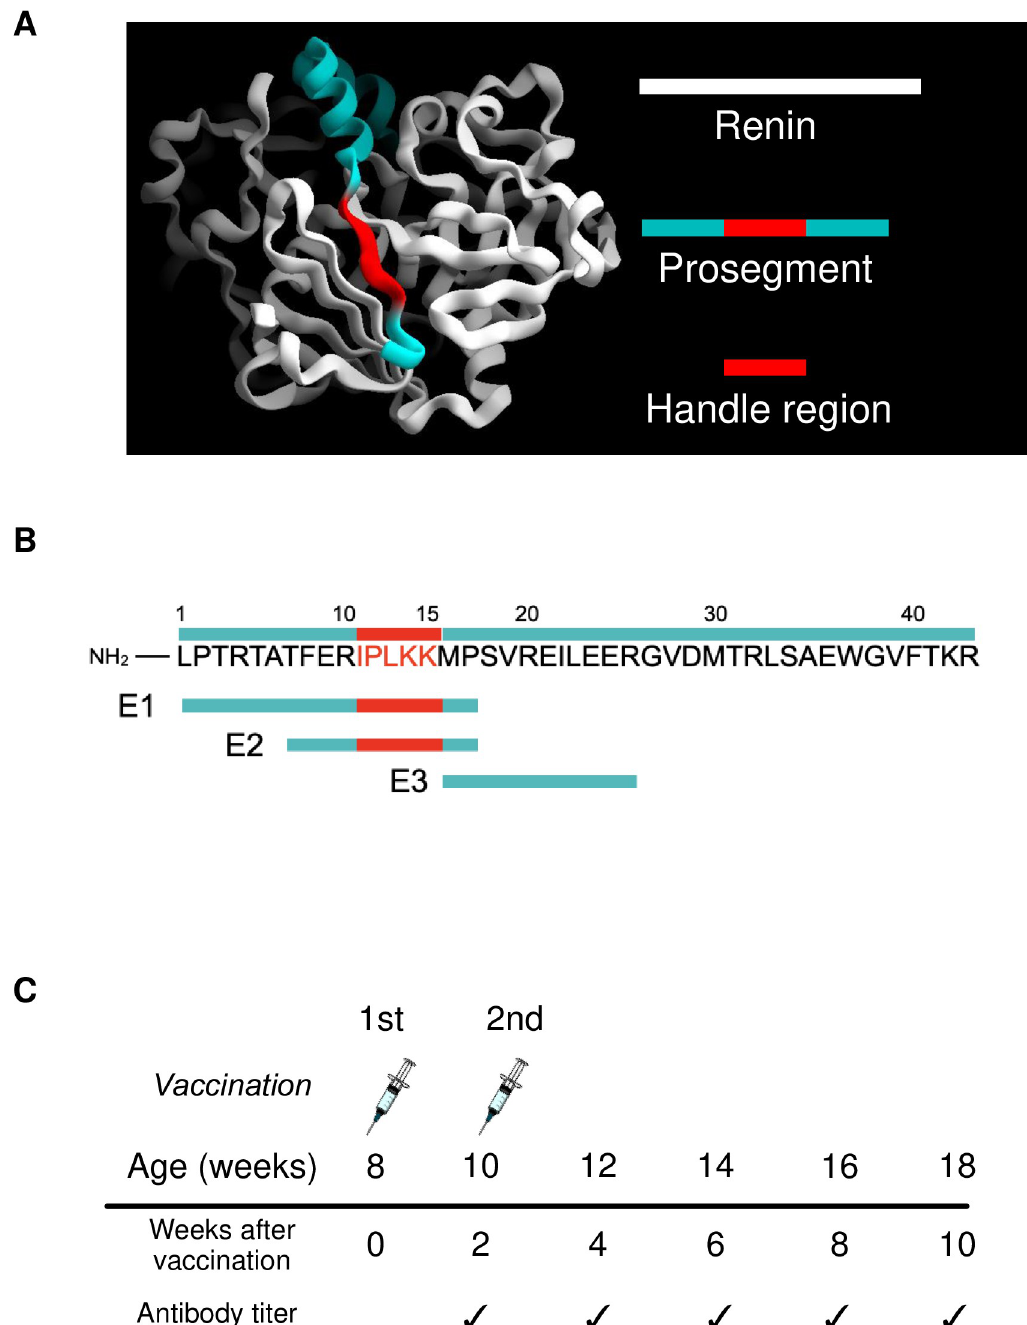
Fig 1. Planning of optimization of prorenin peptide vaccine. (A) Tertiary structure of prorenin. Prorenin consists of the prosegment (blue and red) and mature renin (white). (B) Antigen E1 and E2 contained the handle region, but E3 did not. (C) Schedule for vaccination and antibody titer